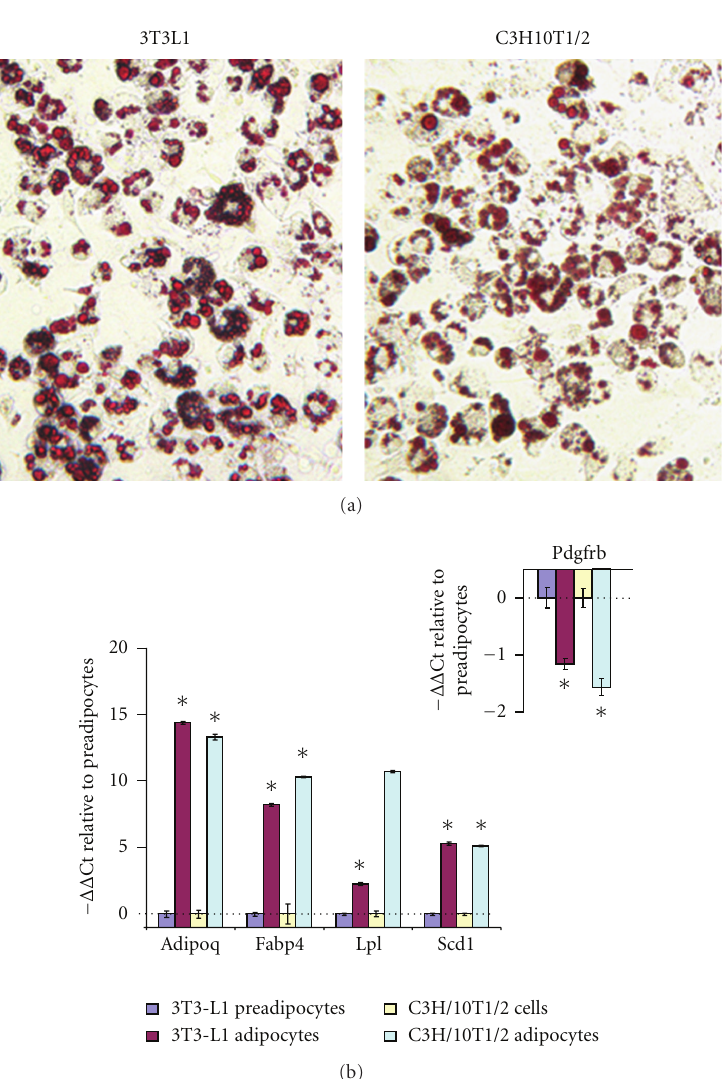
Figure 1: Phenotypic and molecular characterization of 3T3-L1 and C3H/10T1/2 adipocytes after di ff erentiation. Di ff erentiated 3T3-L1 and C3H/10T1/2 adipocytes were stained with Oil Red O ((a) Magnification = 200x). Alternatively, QRT-PCR was performed using RNA extracted from cells prior to and after di ff erentiation (b). Relative mRNA levels of adipocyte markers Adipoq, Fabp4, Lpl, and Scd1, and preadipocyte/fibroblast marker Pdgfrb (inset in (b)) in di ff erentiated cells were compared to those in preadipocytes. The QRT-PCR data were expressed as – ΔΔ Ct, equivalent to log2-transformed fold changes. All numerical data were expressed as mean ± S.E. ∗ P < 0 . 05 compared to the respective